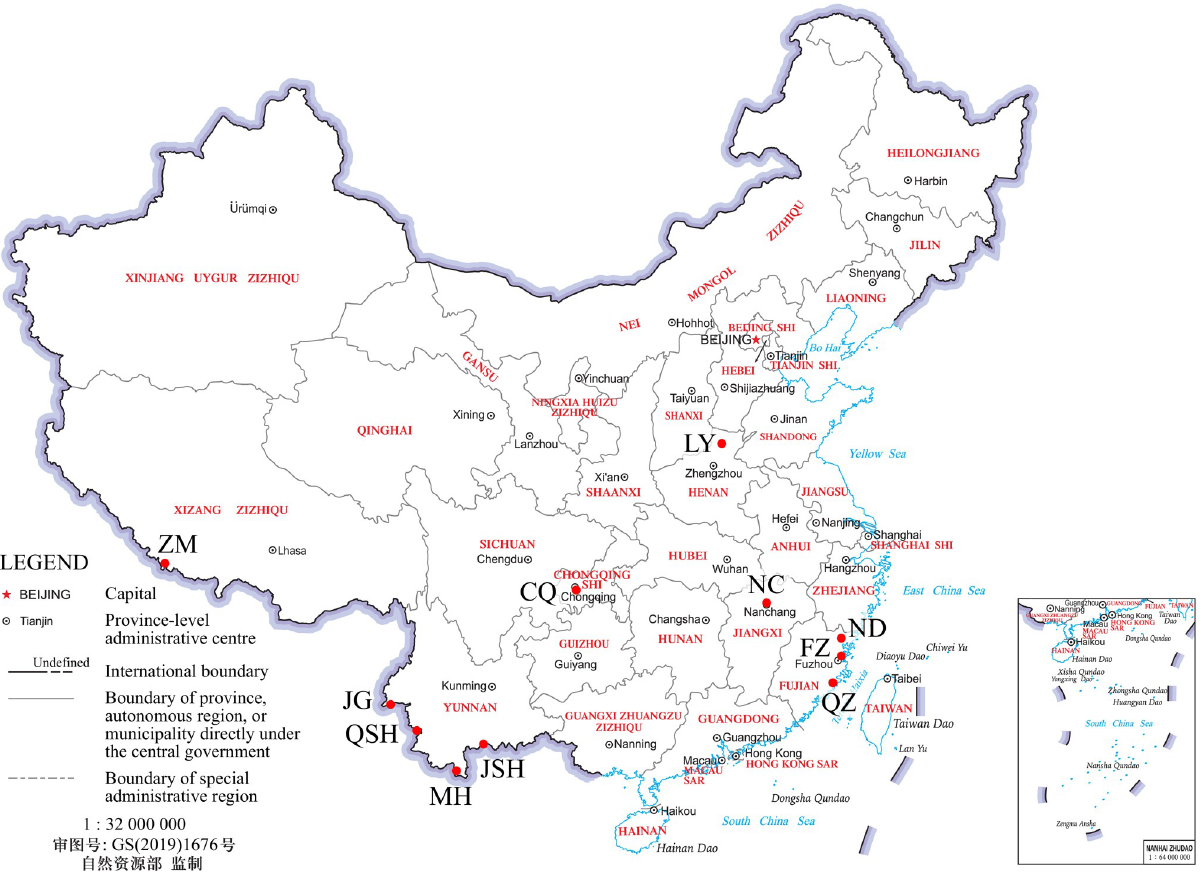
Fig 1. Map showing the distribution of sampling locations.